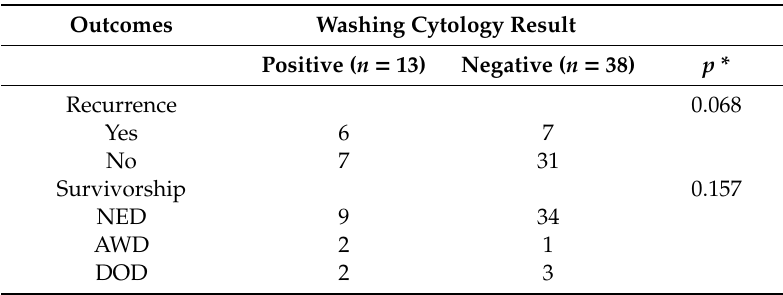
Table 4. Survivorship analysis between cytology results.